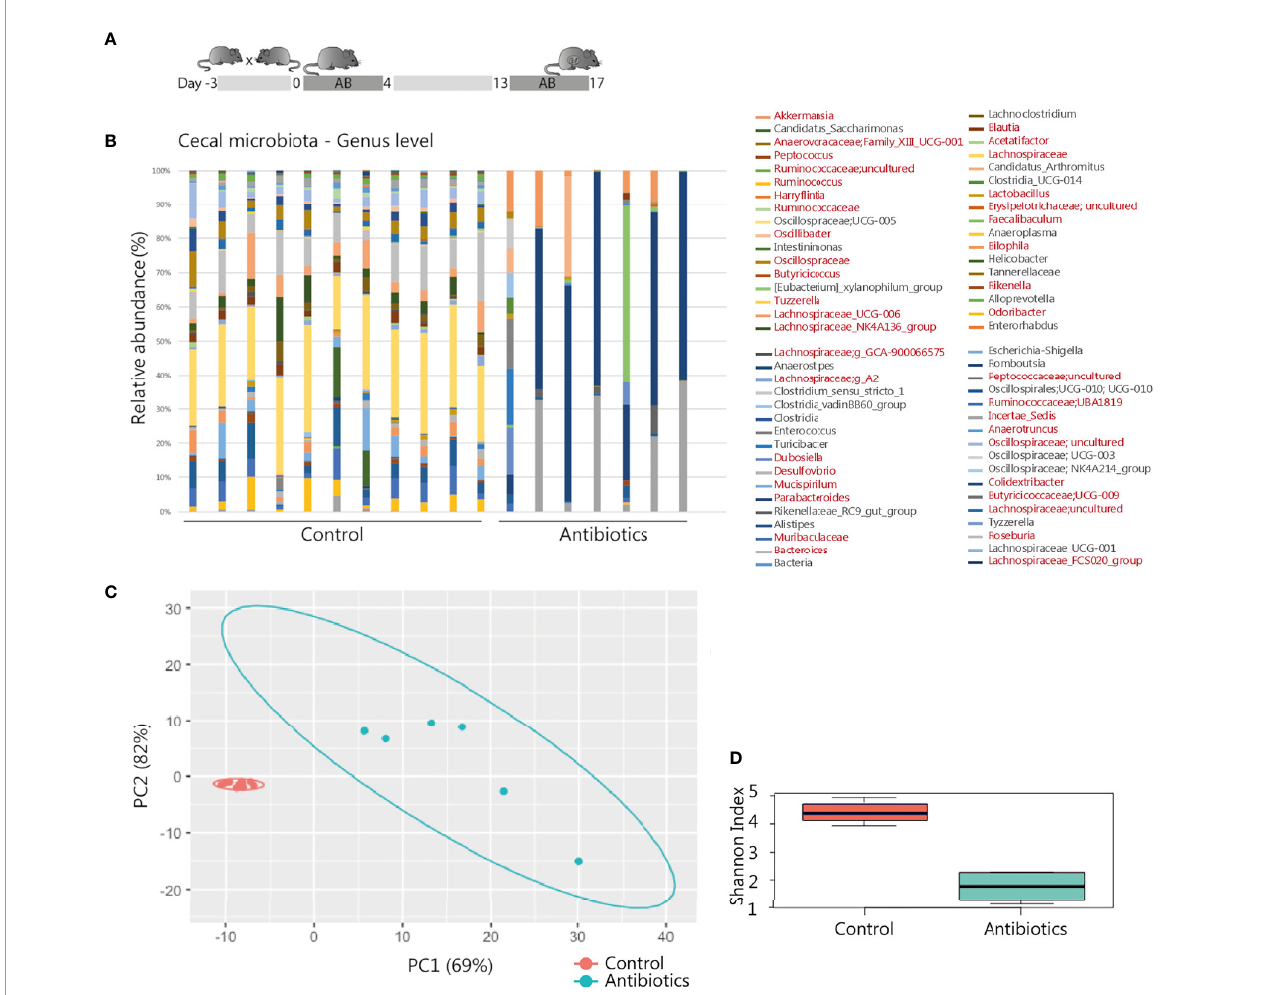
FIGURE 1 | Antibiotic intervention in pregnant BALB/c mice. (A) Schematic representation of the experimental model. After randomly assigning mated mice to the treatment groups, 11 mice of the control and 8 mice of the treatment group were pregnant and included for further analysis. (B) 16S rRNA composition of the cecal samples per individual animal (1 sample of the antibiotic treatment group excluded due to read count <500). In the legend, genera shown in red were signi fi cantly affected by the treatment (see also Supplementary Table T1 ). (C) Principal component analysis of 16S rRNA sequencing data on genus level. (D) Shannon Index presenting microbial